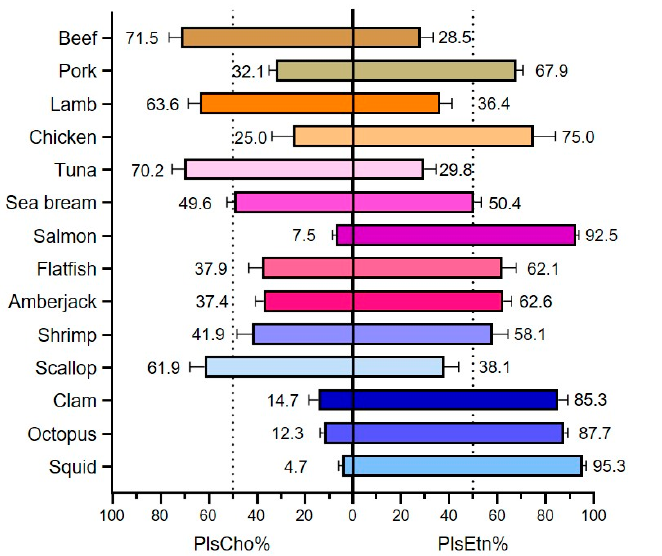
Figure 4. Proportion of ethanolamine and choline as the plasmalogen headgroup in foodstuffs. Data were normalized as percentages and shown as means ± SD.